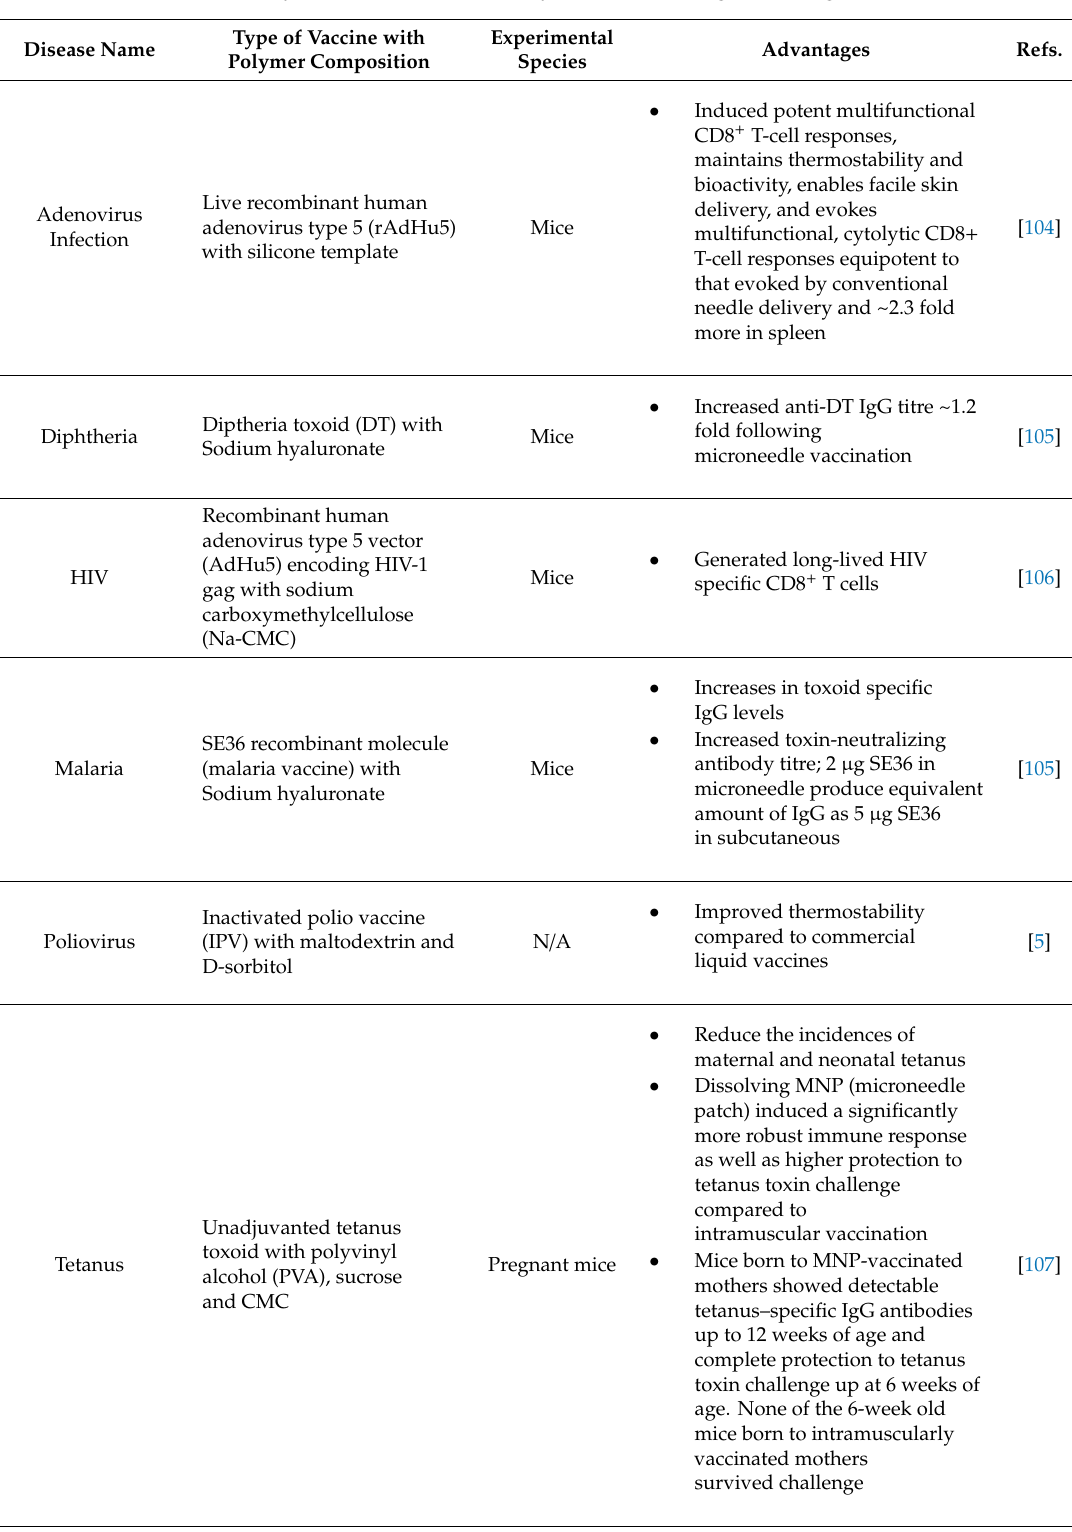
Table 3. A summary of studies on the delivery of vaccines using dissolving microneedles. Disease